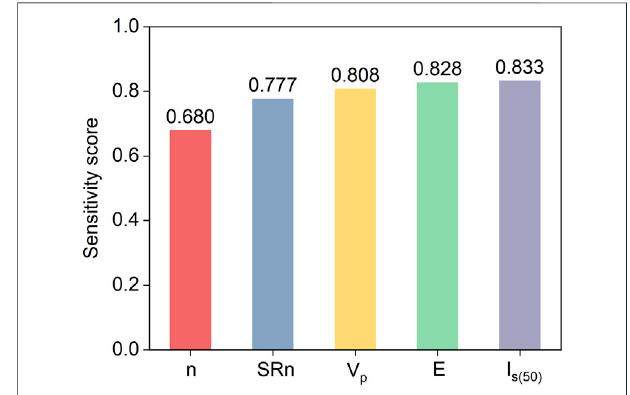
FIGURE 10 | Variations of fi tness value with the number of iterations.